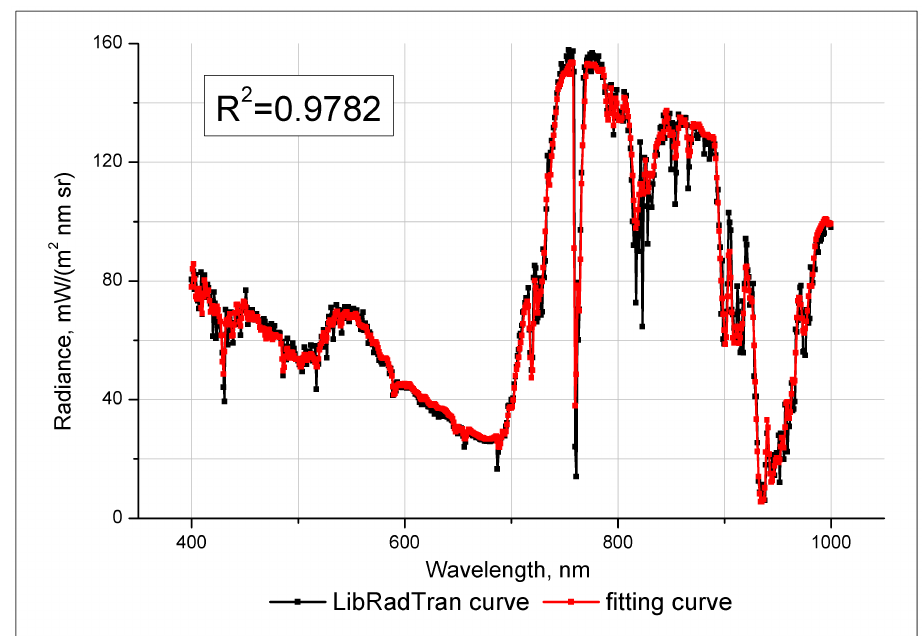
Figure 2. Spectral radiance on the top of atmosphere (TOA) according to LibRadTran calculations and fitting an analytic function